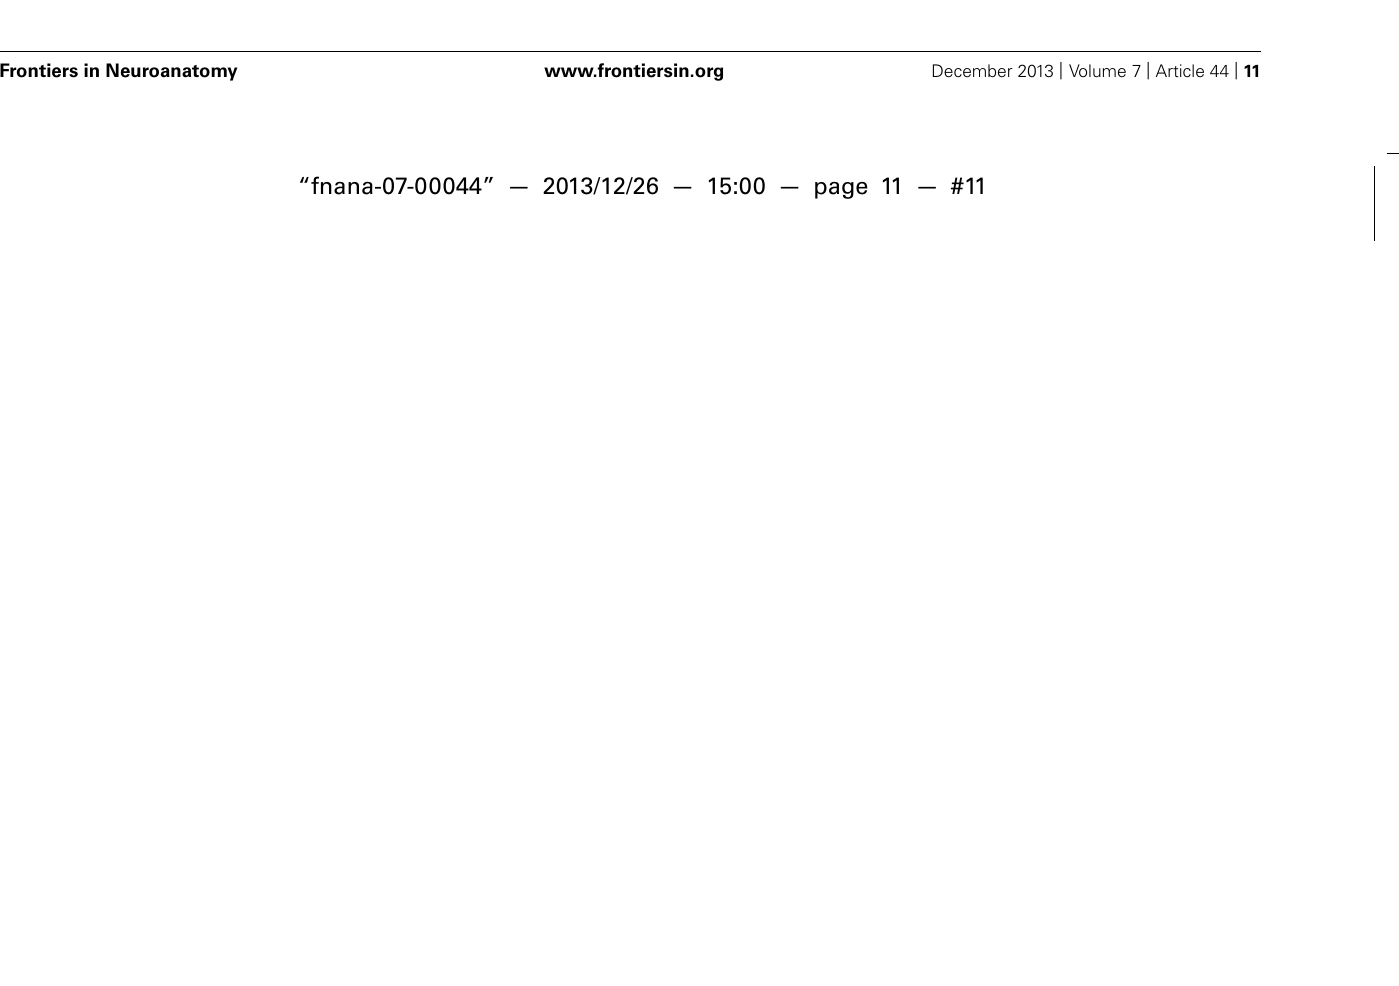
anterior horn of the spinal cord. Neuron counts were restricted to the neurons with a well-defined nucleolus and a cell body with adequate amounts of endoplasmic reticulum, in three visual fields/per section with 200 × magnification under bright field viewing. Surviving neural cells (each group % of the normal control) in different groups at week 2 (K) and week 8 (L) post-immunization, calculated after Nissl staining. a P < 0.05 versus the normal control; b P < 0.05 versus vehicle-treated EAE